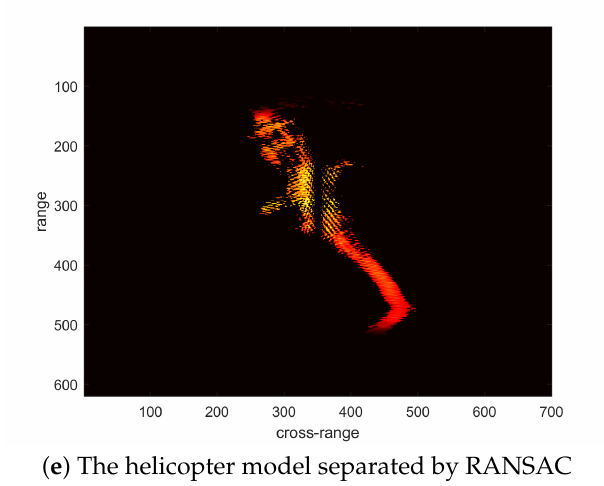
Figure 5. Simulation of the helicopter